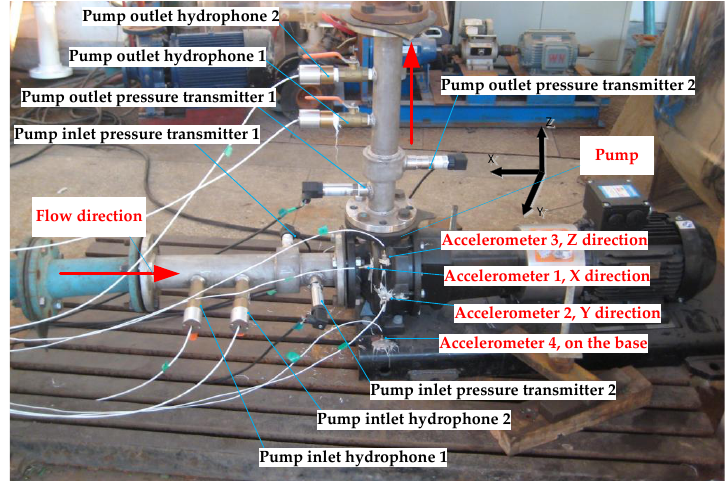
Figure 4. Experimental set up with instrumentations.